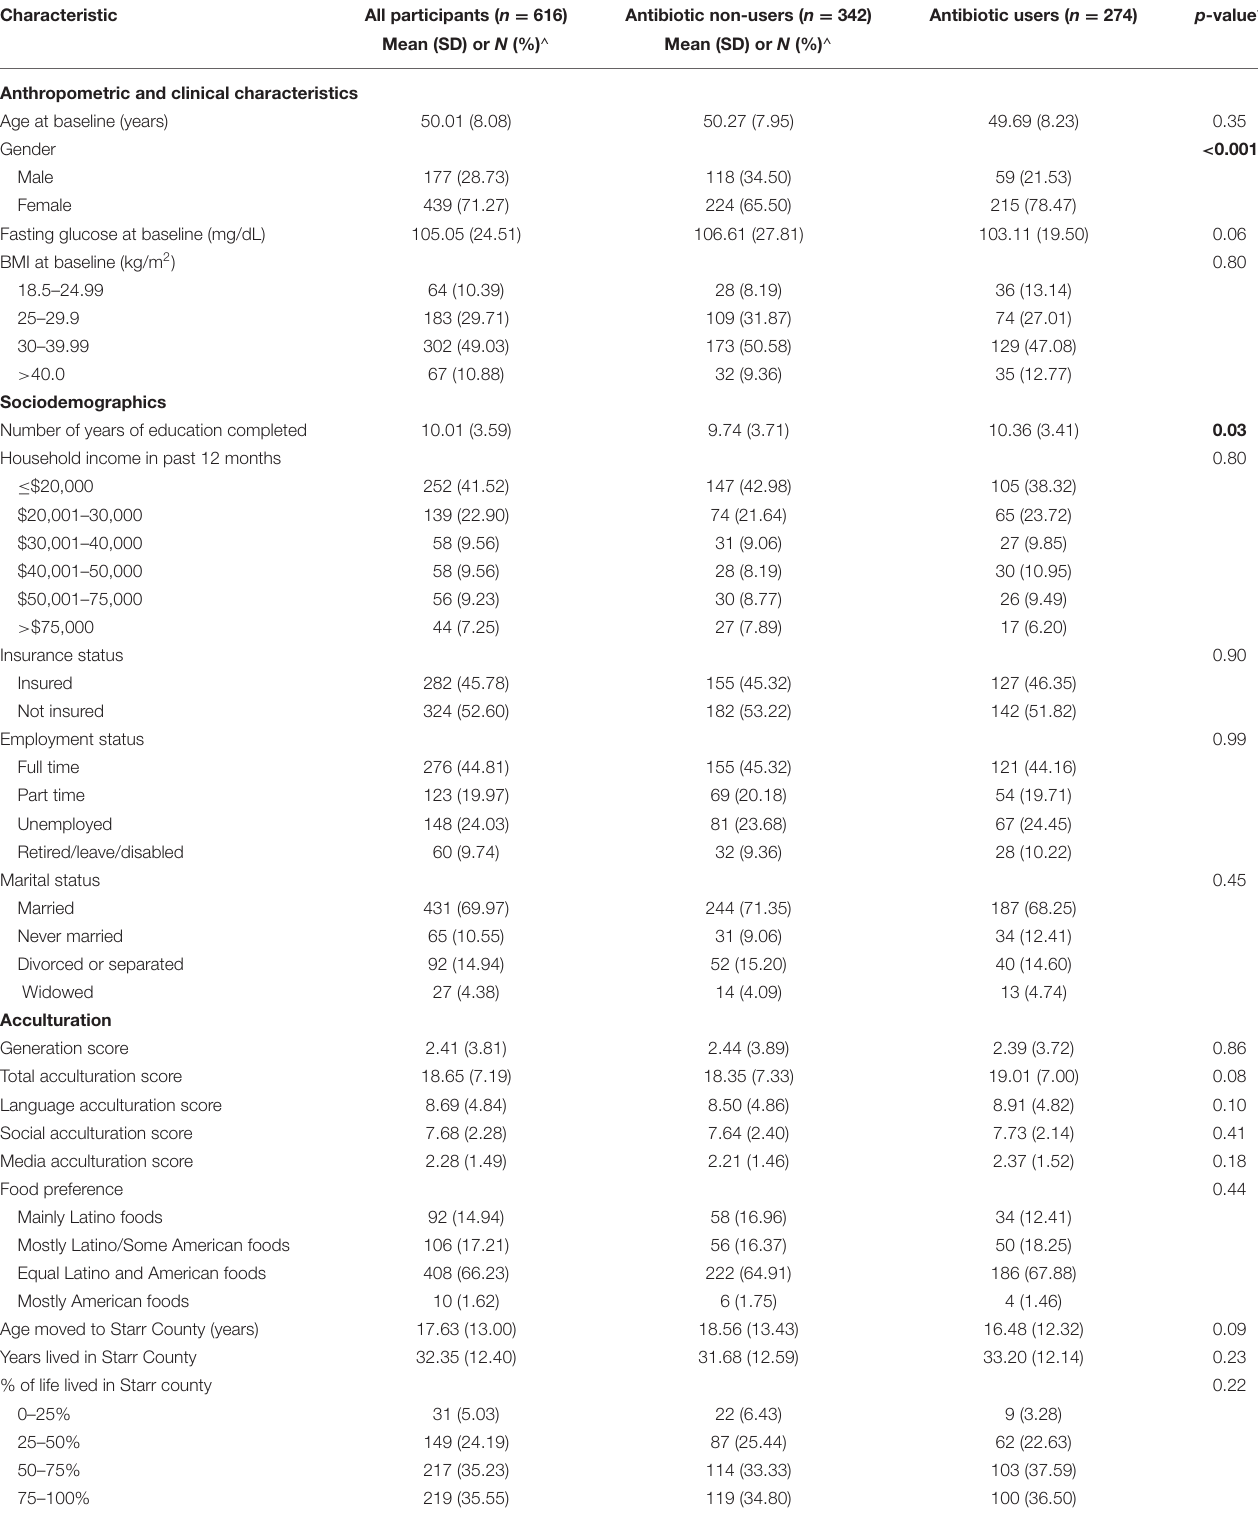
TABLE 1 | Descriptive statistics of the baseline cohort stratified by any antibiotic use in the past 12 months.